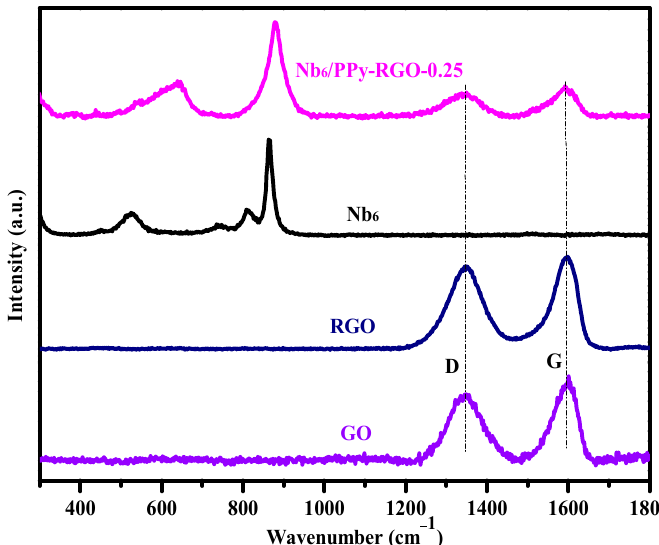
Figure 3. Raman spectra of Nb 6 , GO, RGO and Nb 6 /PPy-RGO-0.25.